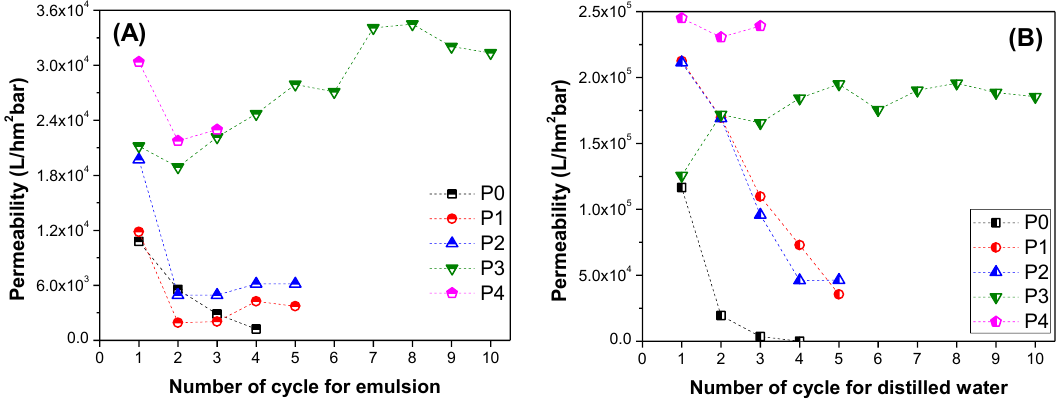
Figure 10. Permeability vs the number of cycles for ( A ) oil–water, and ( B ) distilled water.